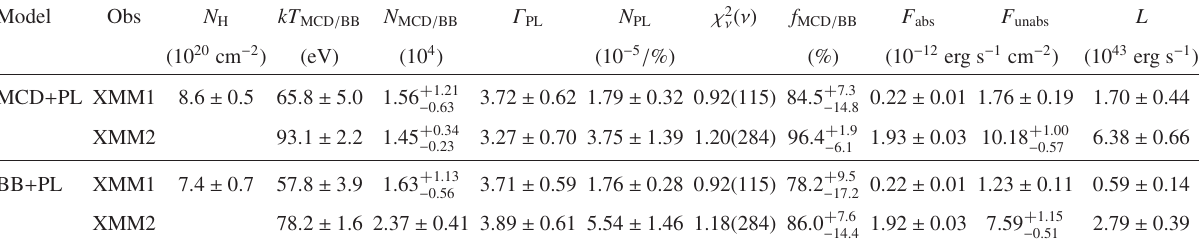
Table 1. Spectral modeling results [19]. The column f MCD / BB refers to the unabsorbed flux fraction of the MCD or blackbody (BB) component in the 0.2–10 keV energy band. F abs and F unabs are the total absorbed and unabsorbed fluxes in the 0.2–10keV energy band, respectively. The luminosity L was calculated using the unabsorbed bolometric flux of each spectral component (the PL component was integrated down to 0.2keV). All errors are at a 90%-confidence